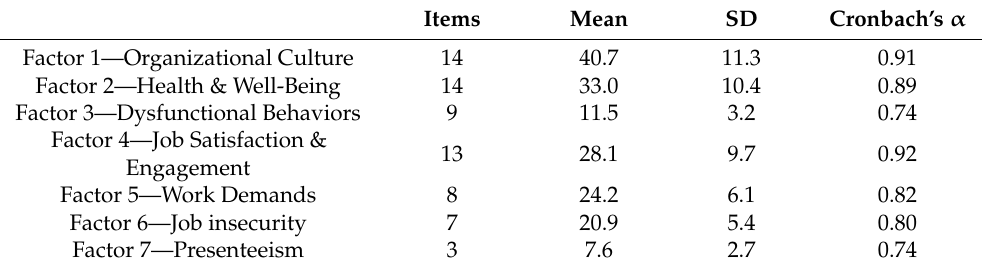
Table 5. Descriptive statistics and internal consistency coefficients (Cronbach’s alpha) for the PRIWA scales (Sample 3, N = 494).